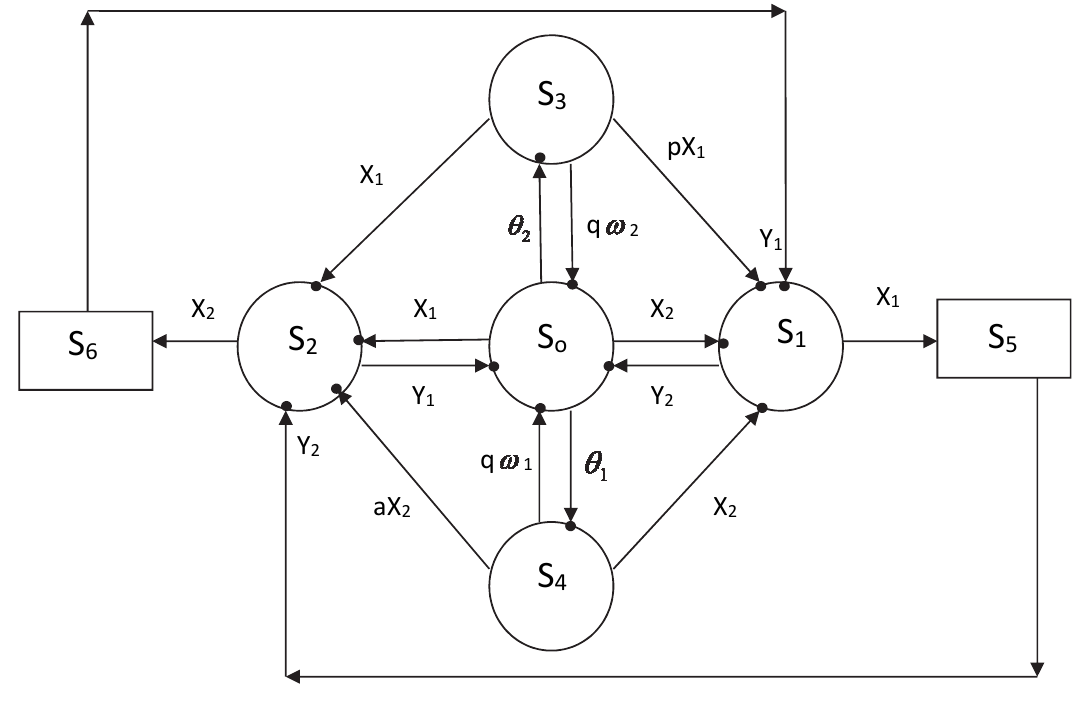
Fig. 1. Transition